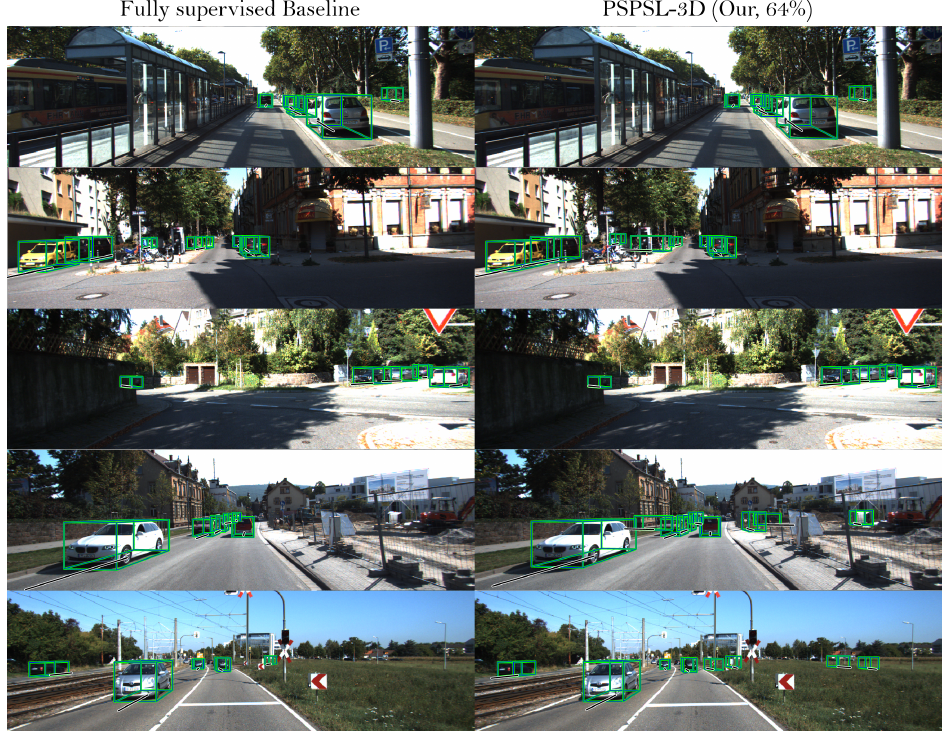
Figure 3. 3D object detection results of the fully supervised (FS) baseline method and the proposed PSPSL-3D trained in R anno = 64%-labeled data in the KITTI validation